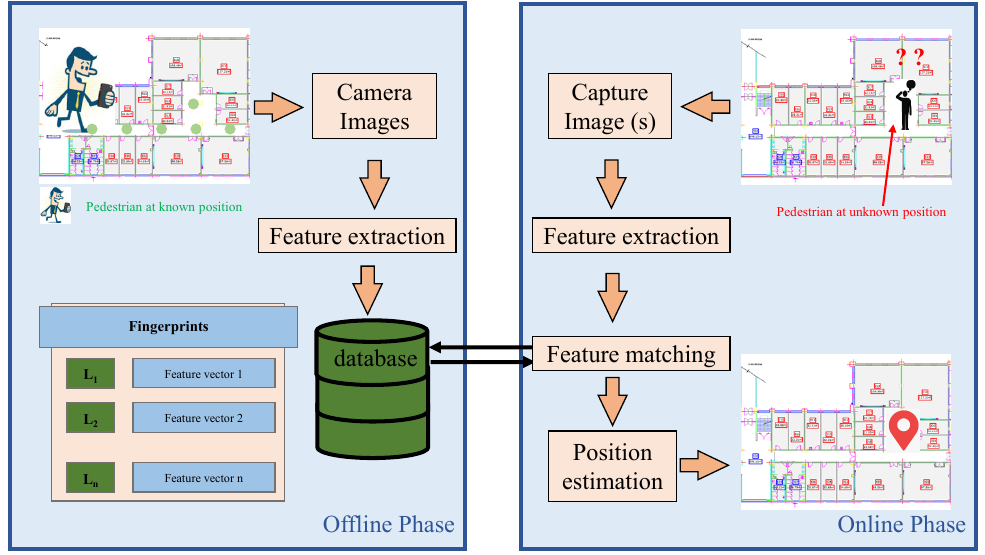
Figure 9. The architecture of a smartphone camera-based localization